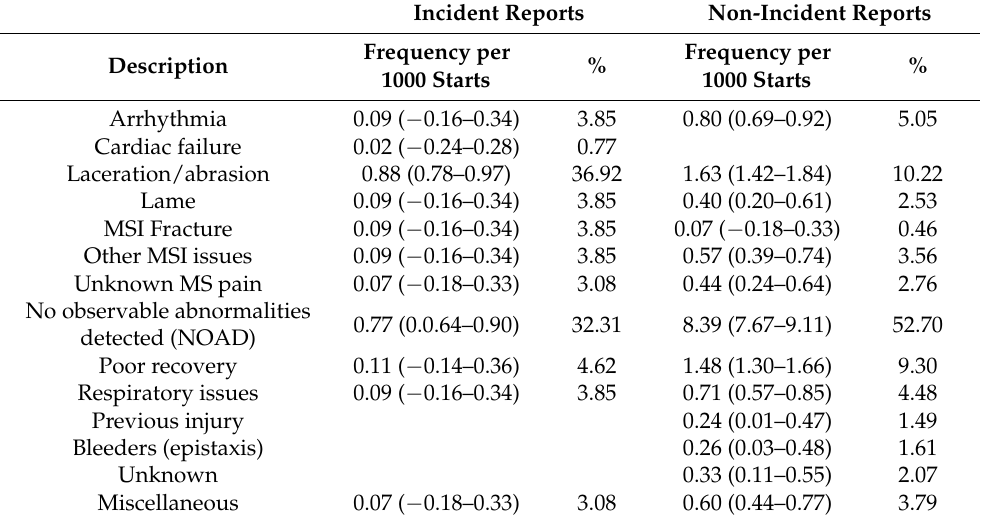
Table 2. Frequency of clinical findings in incident ( n = 130) and non-incident ( n = 871) stipendiary reports over 2 complete harness racing seasons. Data are reported as frequency per 1000 starts (with 95% confidence intervals) and the percentage of clinical findings within the respective report type (incident or